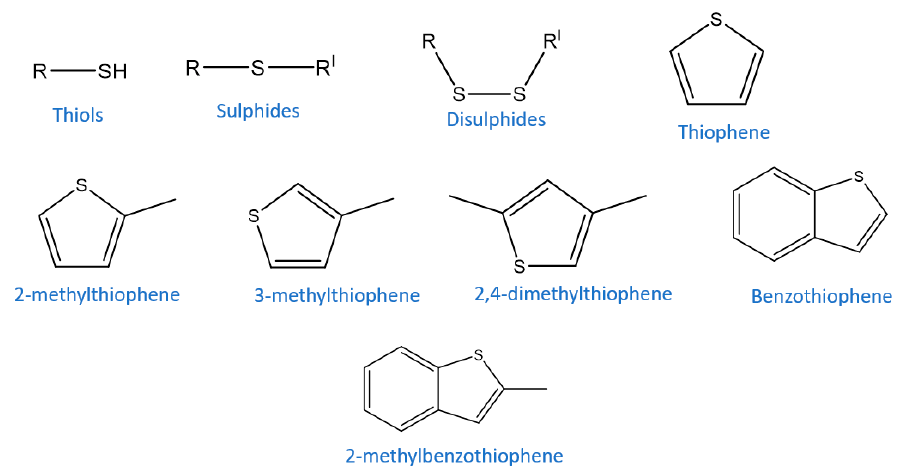
Figure 1. Sulfur compounds present in crude oil.